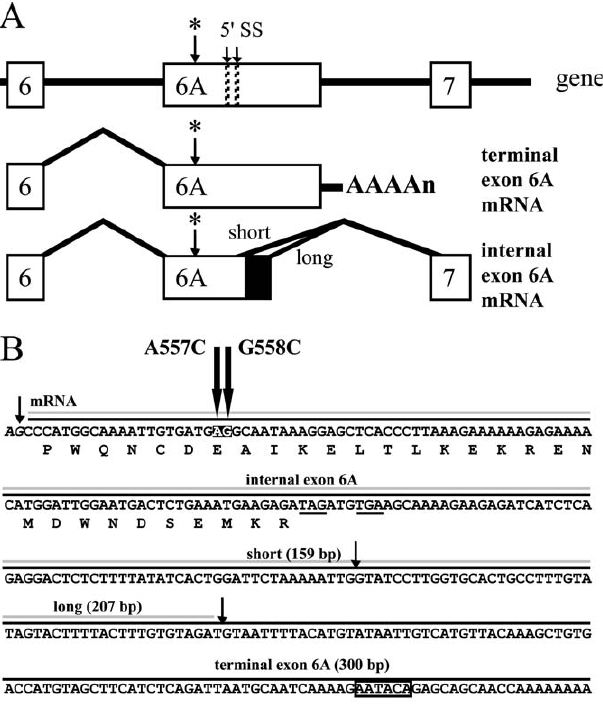
Figure 1. Identification and Characterization of Exon 6A (A) Upper diagram: Schematic representation of the composite internal/ terminal exon 6A and its location in the LHCGR gene. The asterisk indicates the translational stop codon. 5 9 SS indicates the 5 9 splicing sites. Middle diagram: Structure of the LHCGR mRNA when exon 6A is acting as a terminal exon. Lower diagram: Structure of the LHCGR mRNA when exon 6A is acting as an internal exon. (B) cDNA nucleotide sequence and putative amino acid sequence of exon 6A. The three different variants of exon 6A are indicated by the grey line (internal short and long exon 6A) and black line (terminal exon 6A). Stop codons are underlined and the polyadenylation signal is boxed. The 3 9 and 5 9 splice sites are indicated by small arrows and the position of the identified mutations by bold arrows. Numbering of nucleotides is according to the LHCGR mRNA where the translational initiation codon ATG is considered as þ 1